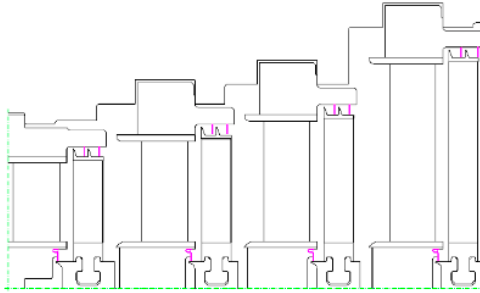
Figure 13. Turbine flow part for Variant 1 and MM working fluid.